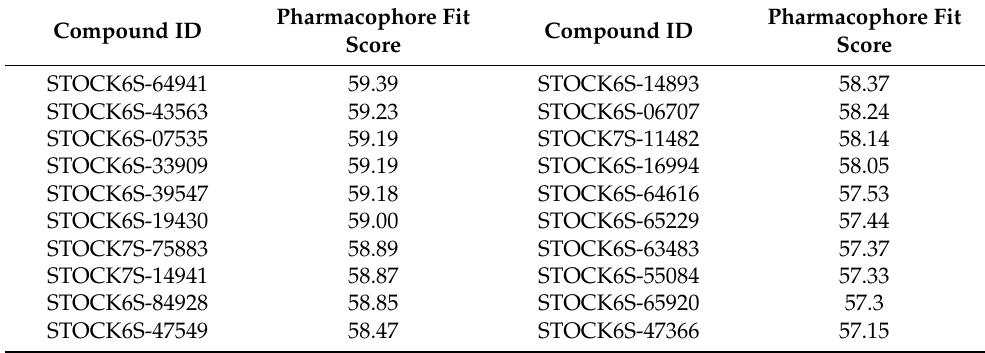
Table 1. Selected compounds with pharmacophore fit scores above 50 via pharmacophore-based virtual